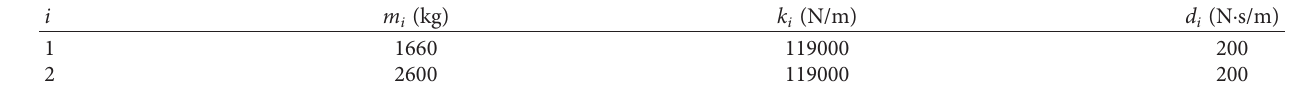
Table 5: Physical parameters of